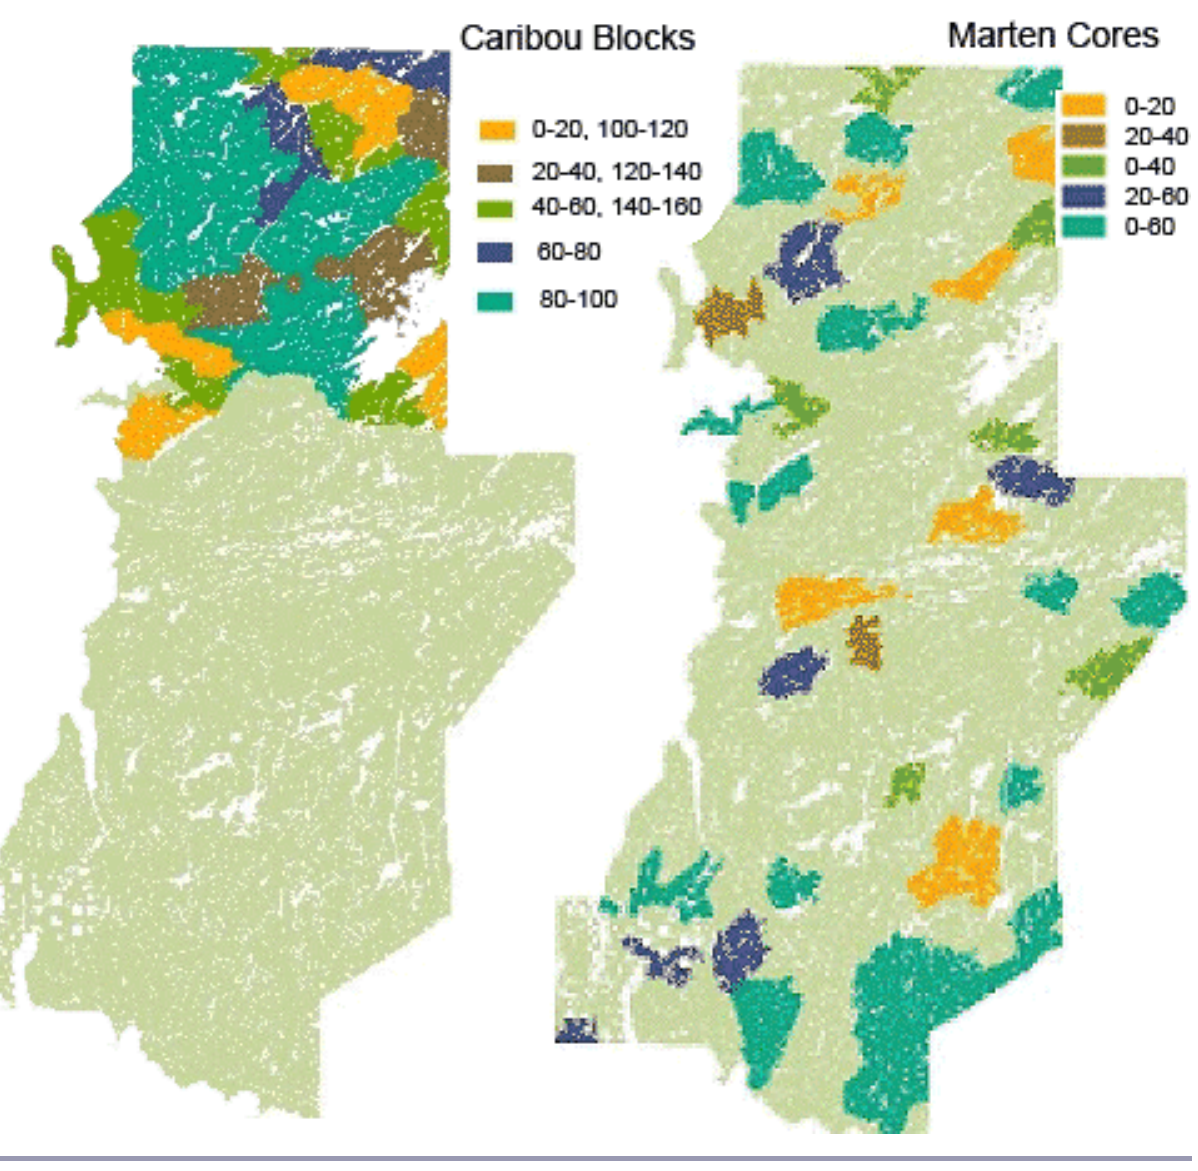
Fig. 5. Sequential timings (years from present) for when blocks are available for harvest (Caribou Blocks), and for when reserve blocks are unavailable for harvest (Marten Core Areas) in the Lake Nipigon forest management unit. These timings are used in both the existing spatial harvest